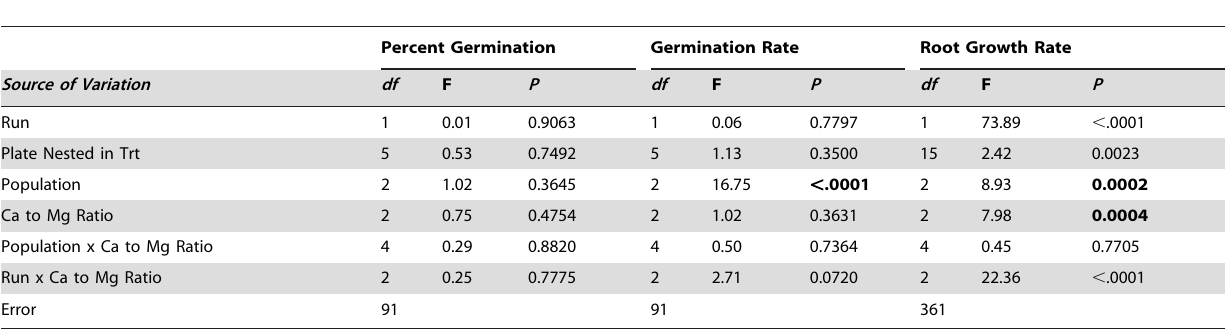
Table 2. ANOVA table for seed germination (percent and rate) and seedling root growth rate of three A. l. ssp. lyrata populations exposed to different substrate Ca to Mg ratios.